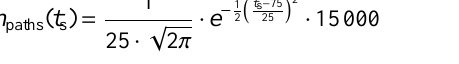
Figure 4. Simulation of the total current, I total , for sensors with different conductive coatings leading to base resistances (without soot) of 3 k Ω , 30 k Ω , and 300 k Ω , see Table 1,compared to a blank sensor. Coating thickness b = 11 µm.